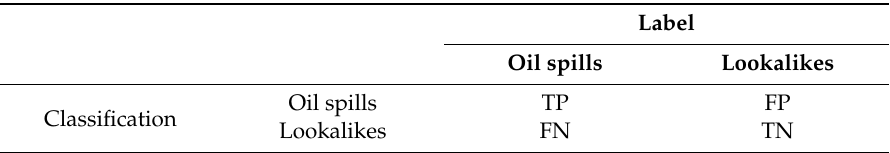
Table 7. Confusion Table 7. Confusion Matrix.